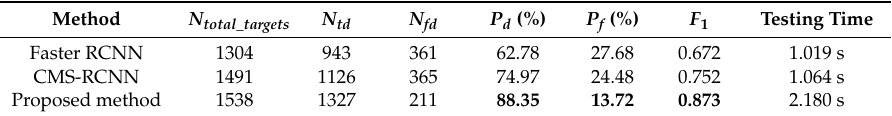
Table 3. Detection performance comparison between different methods.